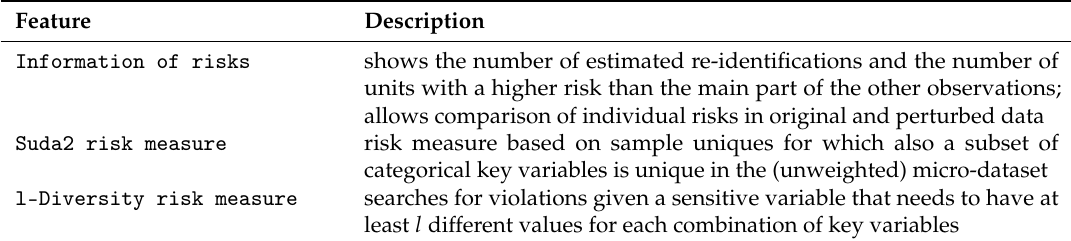
Table 7. Risk measures and information for categorical key